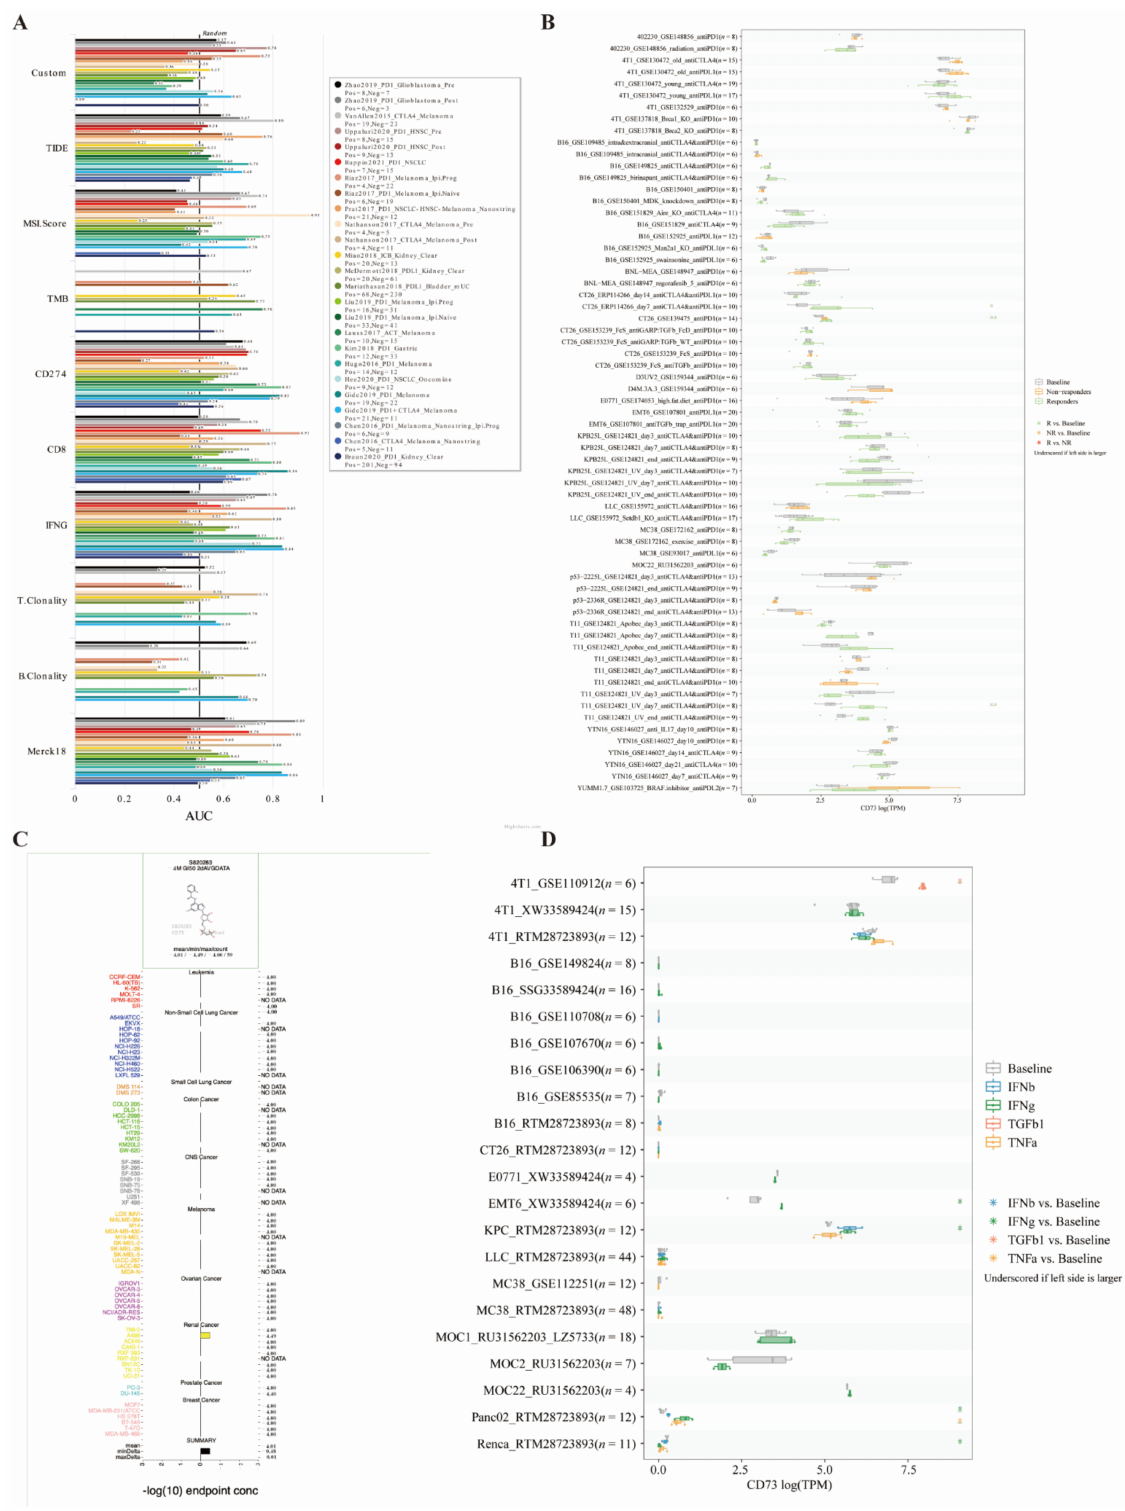
Figure 9. CD73 has high therapeutic values in the immunotherapy cohort. Immunotherapy response in cohorts ( A ) and in vitro ( B ), potent anticancer inhibitors ( C ), and Immunotherapy response in vivo ( D ) of CD73 were identified from the public